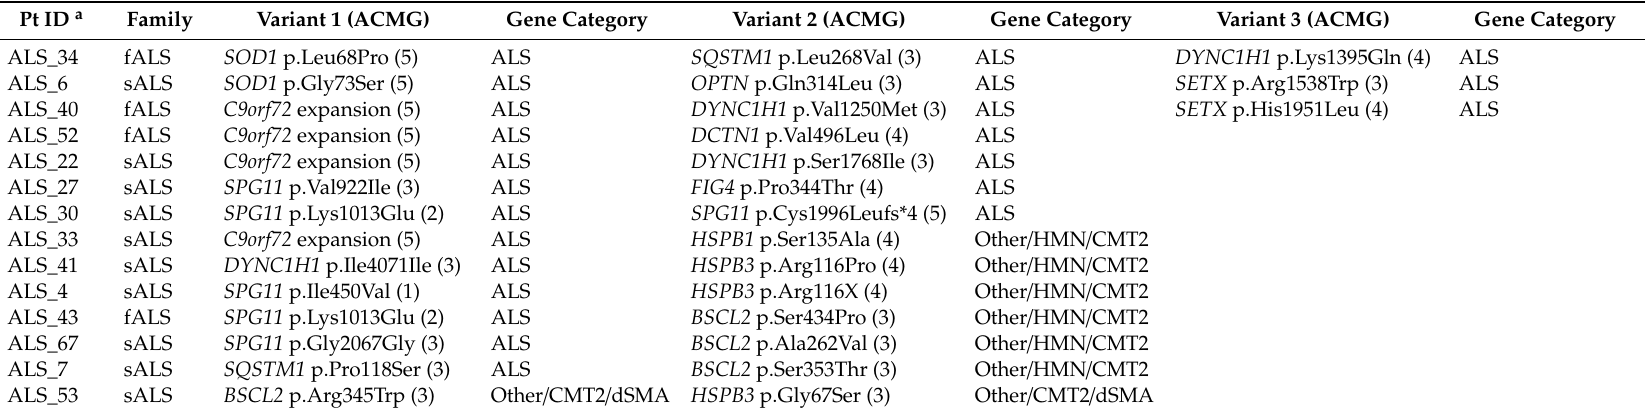
Table 2. List of patients with multiple variants of interest.